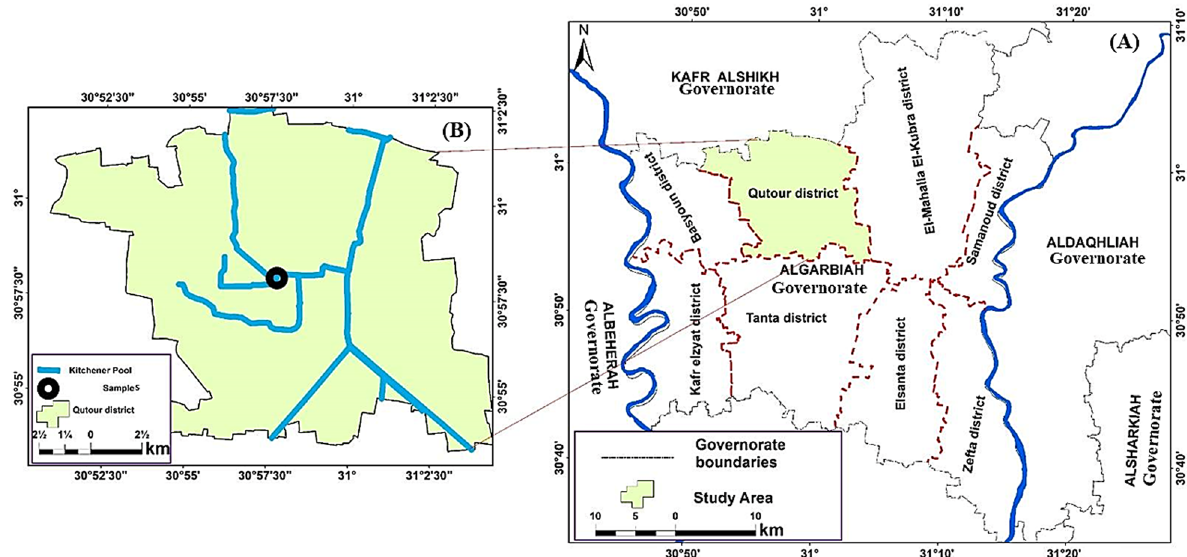
Fig. 2 A Map of the study area in Gharbia Governorate (Qutour district); B small map of the location of samples at Kitchener pool in Qutour district in the